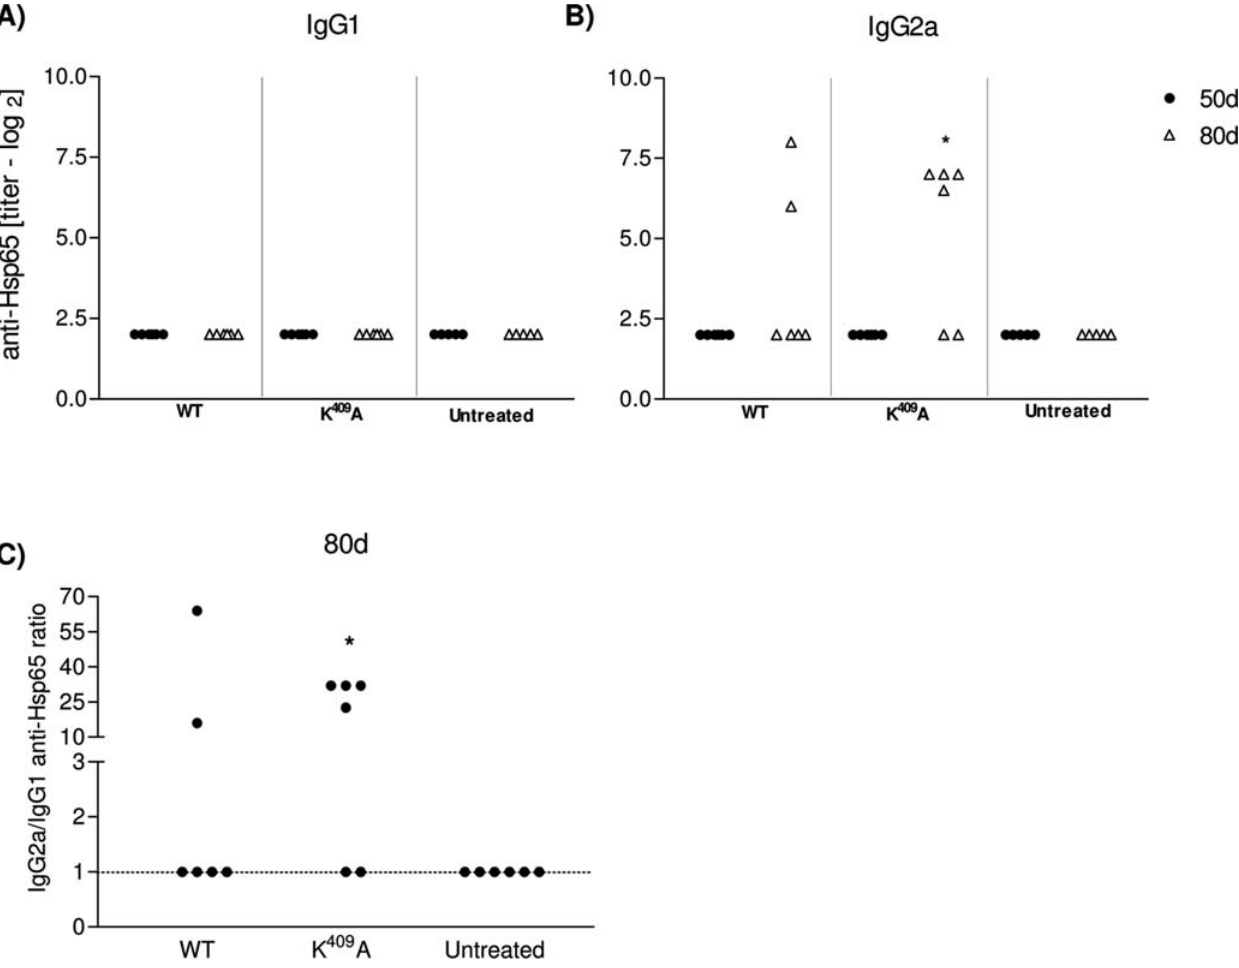
Figure 3. WT and K 409 A rHsp65 treatment in anti-Hsp65 antibody response. Anti-Hsp65 IgG1 [A] and IgG2a [B] antibody production, respectively, in the serum of treated and untreated [NZBxNZW]F 1 mice of 50 and 80 days-old [n=5–6/group]. IgG2a/IgG1 anti-Hsp65 antibody